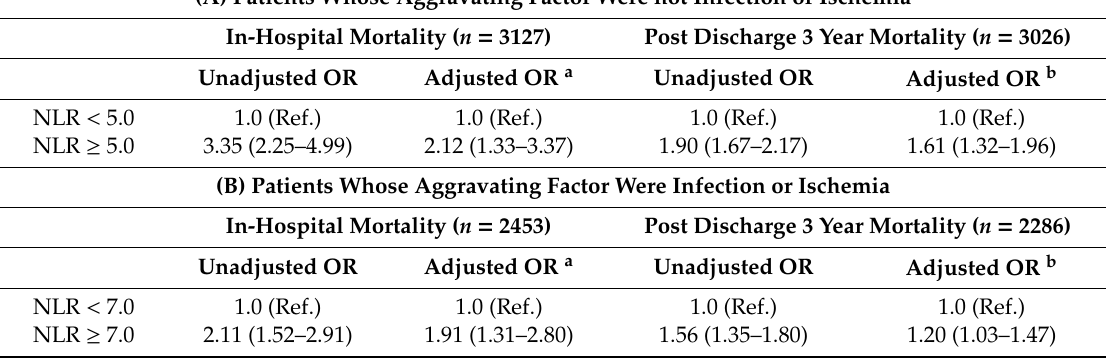
Table 6. Univariate and multivariate logistic regression analyses for all-cause in-hospital and post discharge 3-year mortality in HF patients subgroup analysis by aggravating factor stratified by neutrophil-lymphocyte ratio (NLR) cuto ff